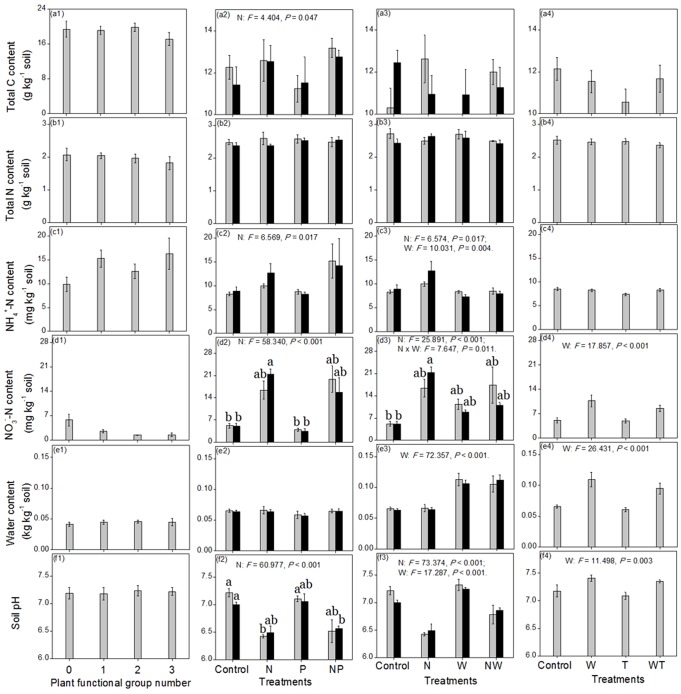
The effects of different treatments on six soil physicochemical indexes.Error bars represent one standard error. For clarity, only the statistical results with P<0.05 are shown. 0, 1, 2 and 3 for the x axis in a1–f1 represent the remained PFG number. M, N, P, W and T in a2–f4 represent the treatments of simulated mowing, N addition, P addition, watering, and warming, respectively. In a2–f2 and a3–f3, gray and black columns represent the treatments without and with mowing, respectively. There are 5, 4, 4 and 6 replicates for a1–f1, a2–f2, a3–f3 and a4–f4, respectively.